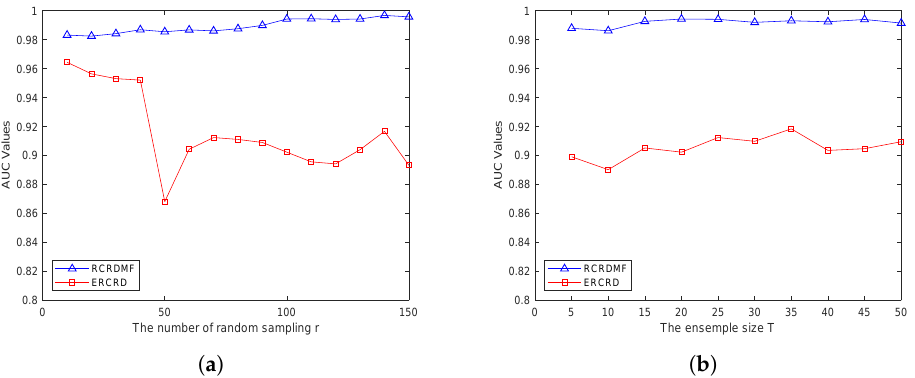
Figure 18. Parameter effect of ( a ) the number of random sampling r and ( b ) the ensemble size T on the Cri